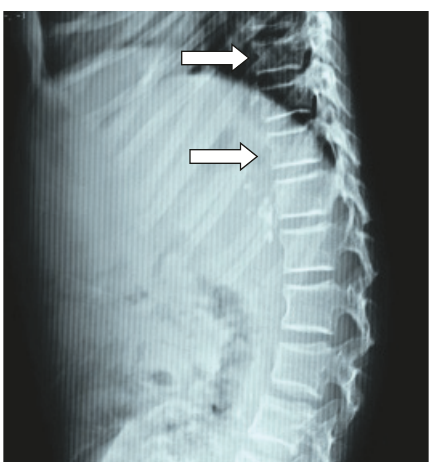
Figure 3: Radiograph of the dorsal spine (lateral projection) showing thoracic kyphosis and mild concavity in the anterior aspect of vertebral bodies (arrows). Prevertebral calcific foci seen adjacent to lower thoracic vertebrae.